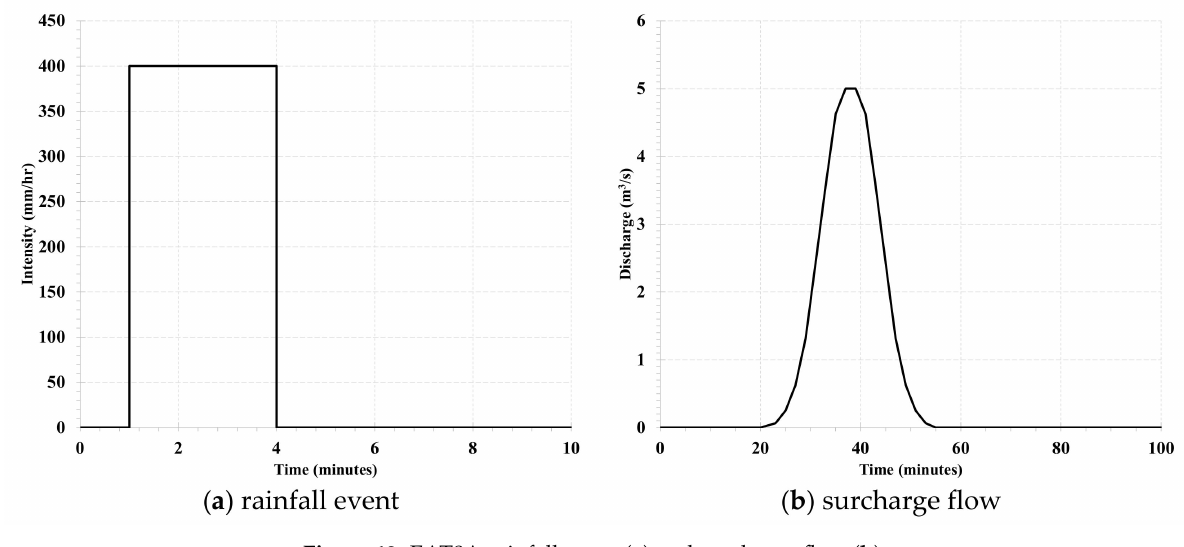
Figure 12. EAT8A rainfall event ( a ) and surcharge flow ( b ).